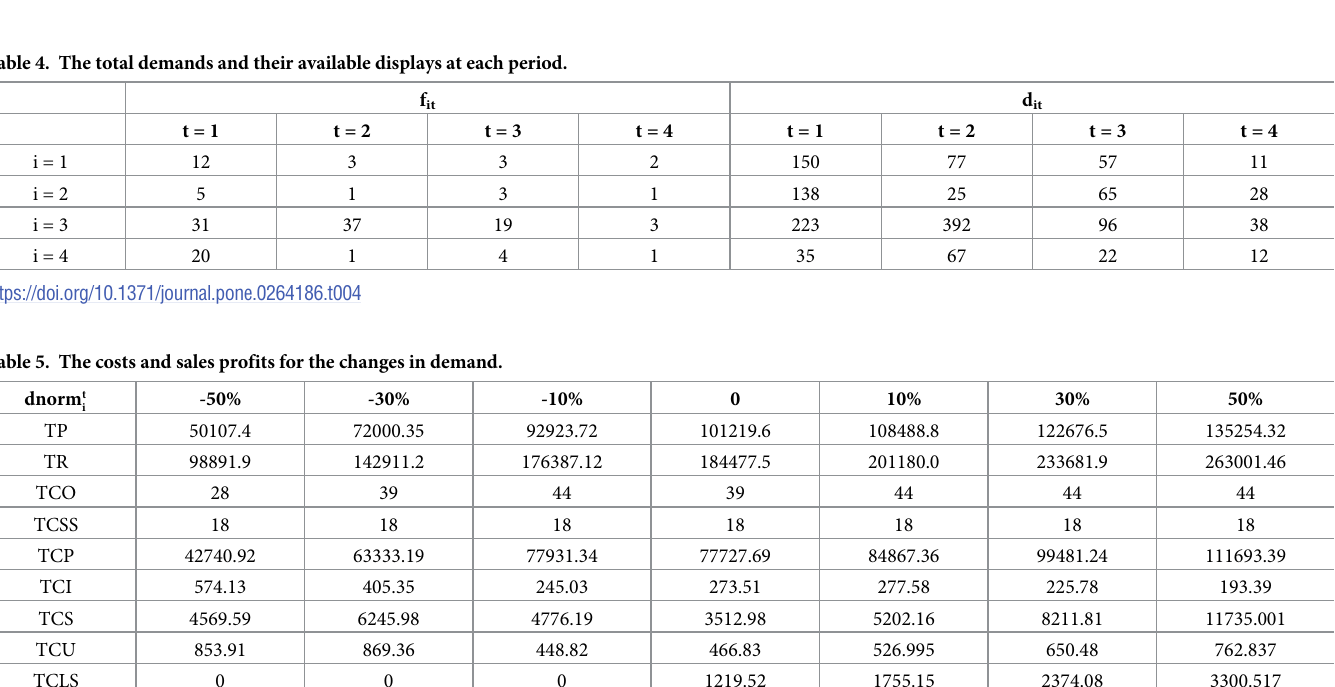
number of products at each display, the total capacity of the shelf, and price. In these analyses, we changed the values of these parameters by 10, 30, and 50 percent from their nominal values (Table 1). The results of these changes are given in their corresponding tables. 5.2.1 Demand SA. Table 5 displays the changes made in costs and sales profits for the changes in the demand parameter. The behavior of these changes can be seen well in Fig 5. According to Table 5 and Fig 5, the sales income and profit increased by the increase in demand. By the demand increase, the amount of inventories at the end of periods reduced and thus the purchasing costs increased. On the other hand, due to the limited space of the shelves to be allocated to the products, the shortage and its associated costs increased. 5.2.2 Price SA. Table 6 displays the changes in the costs and sales profits due to the changes in the price parameter. The behaviors of these changes are shown in Fig 6.